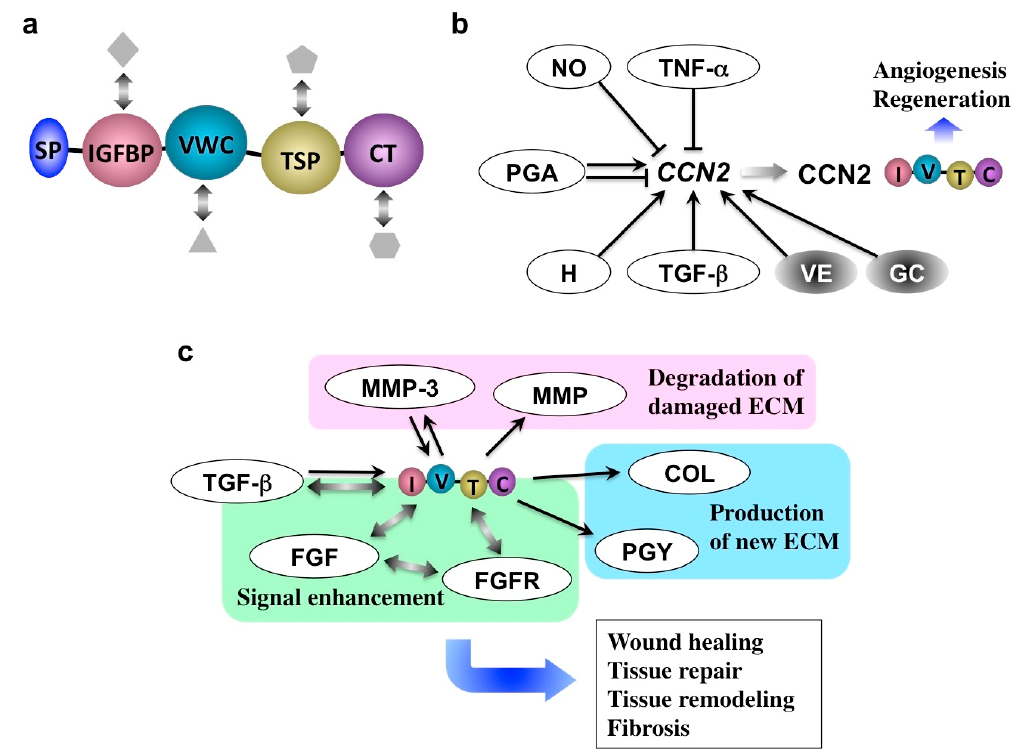
Figure 5. ( a ) Molecular structure of CCN2. Following the signal peptide for secretion (SP), insulin-like growth factor binding protein-like (IGFBP), von Willebrand factor type C repeat (VWC), thrombospondin type I repeat (TSP), and C-terminal cystine knot (CT) modules are connected in tandem. Interaction with multiple co-factors (objects in grey) that support the function of CCN2 is also illustrated. ( b ) CCN2 inducers and repressors. TNF- α , tumor necrosis factor alpha; NO, nitric oxide; PGA, prostaglandin; H, histamine; TGF- β , transforming growth factor beta; VE, vitamin E; GC, glucocorticoid. ( c ) Molecular action of CCN2. MMP, MMPs other than MMP-3; COL, collagen; PGY, proteoglycan; ECM, extracellular matrix; FGFR, fibroblast growth factor receptor; FGF, fibroblast growth factor. Arrows and T-bars indicate induction and repression, respectively. Bidirectional arrows denote direct molecular interactions.